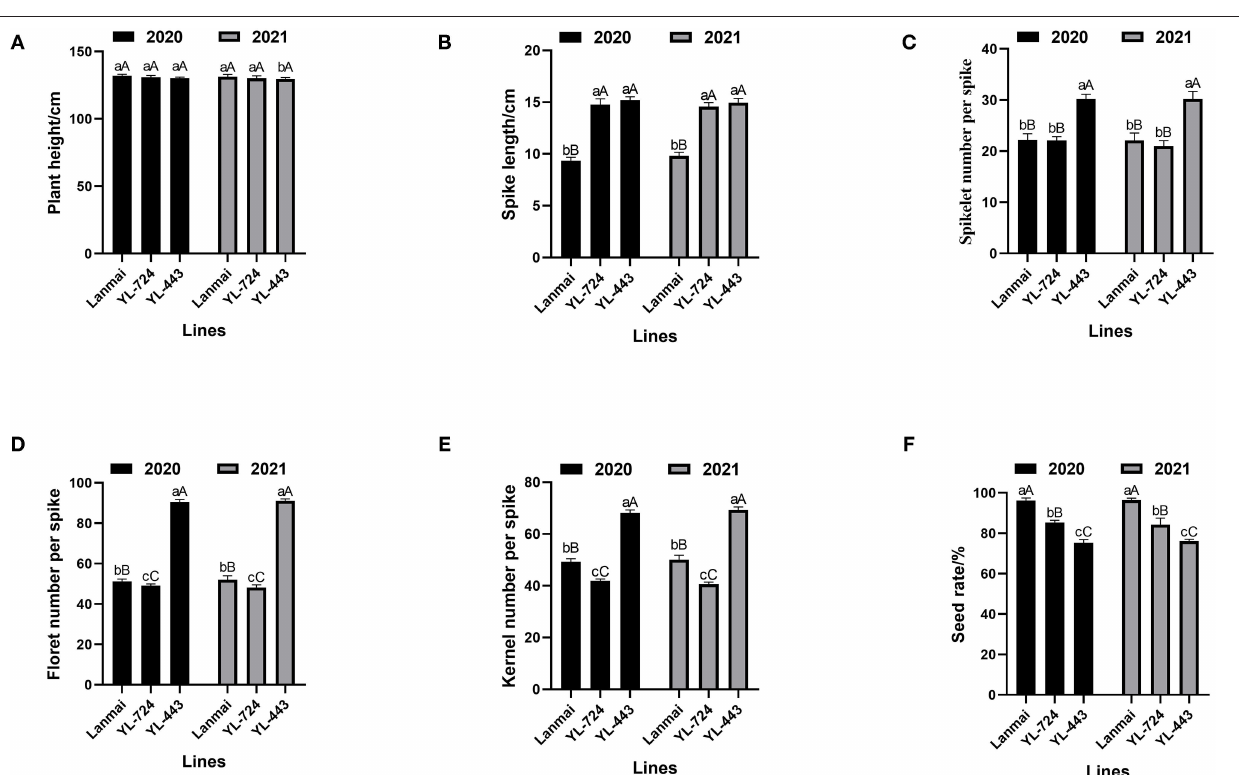
FIGURE 3 | ANOVA of yield component trait of durum wheat Lanmai, Lanmai/AT23 amphiploid line YL-724, Ae. tauschii AT23, and Lanmai 4D(4B) disomic substitution line YL-443. (A) Plant height comparison. (B) Spike length comparison. (C) Spikelet number comparison. (D) Comparison of floret number per spike. (E) Comparison of kernel number per spike. (F) Seed setting rate comparison. The same lowercase letters indicate that the difference among lines was not significant. The same uppercase letters mean the difference between years was not